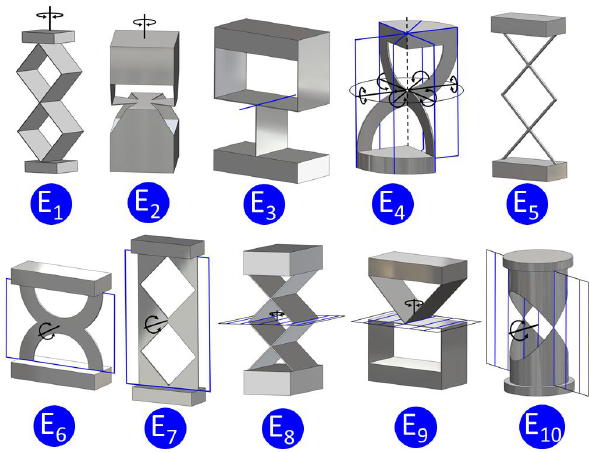
Figure 13. Hybrid flexure element examples 3